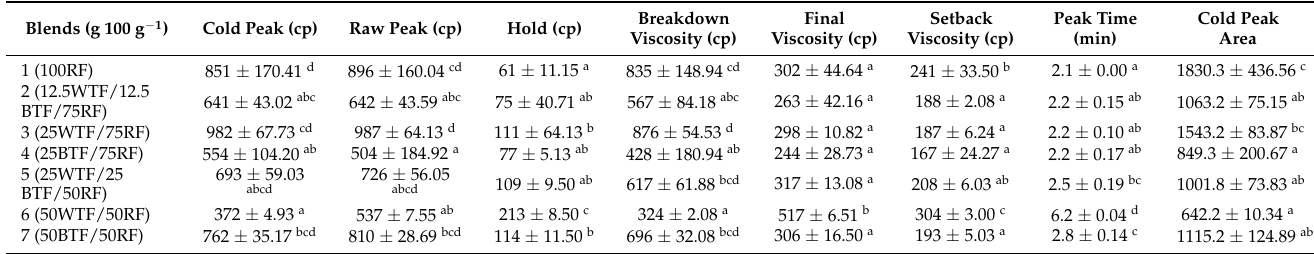
Table 8. Pasting properties of extruded blend flours